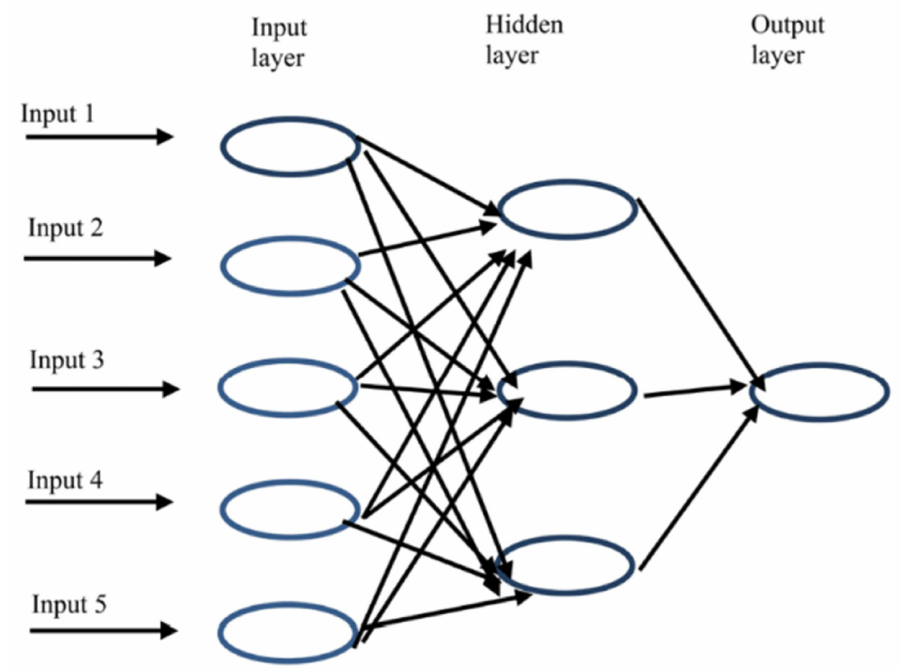
Figure 1. The neural network structure